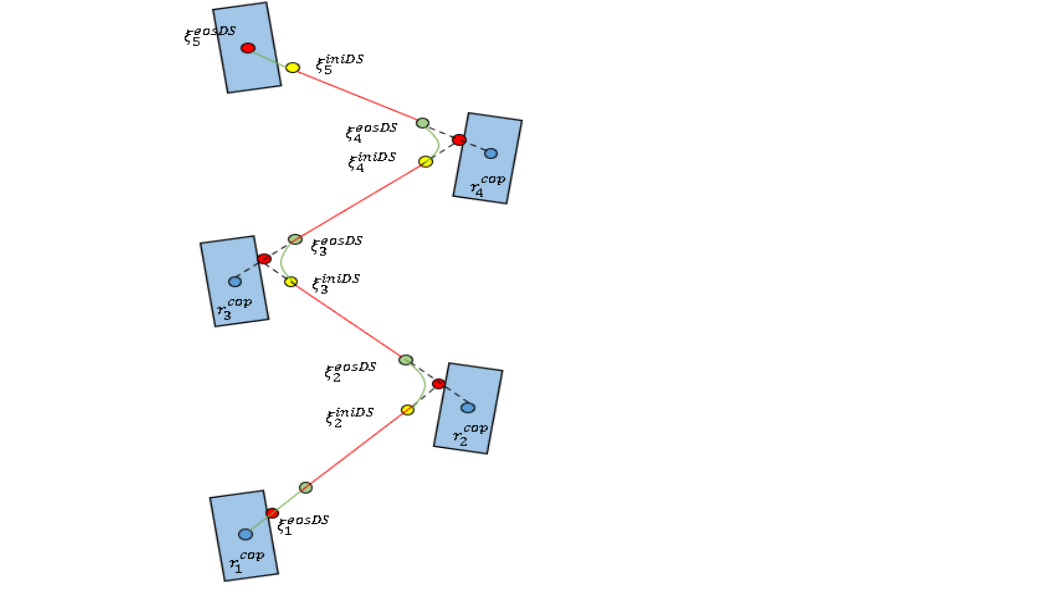
Figure 3. Desired DCM trajectory for the double-support phase.